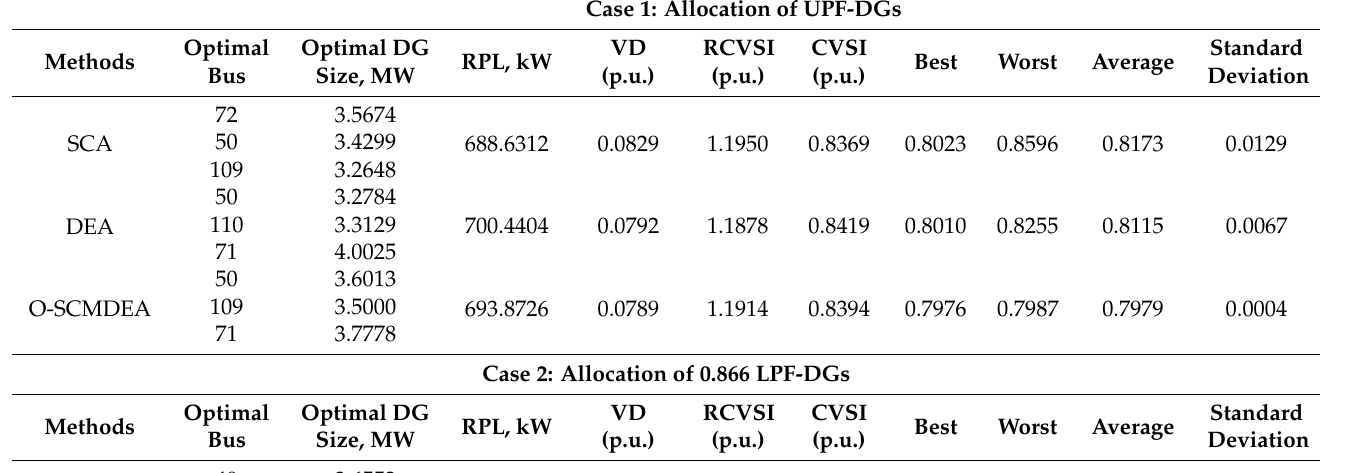
Table 11. Comparison of the results for the simultaneous optimization of the RPL, VD and RCVSI of 118 bus DN.